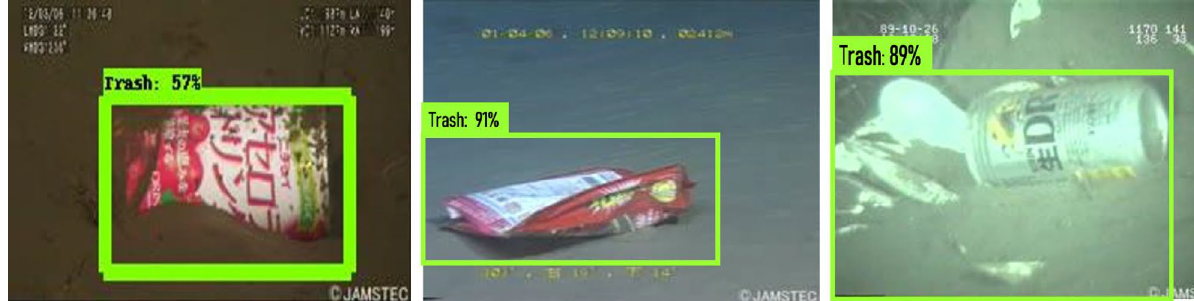
Figure 11. Deep sea data-set detection result.